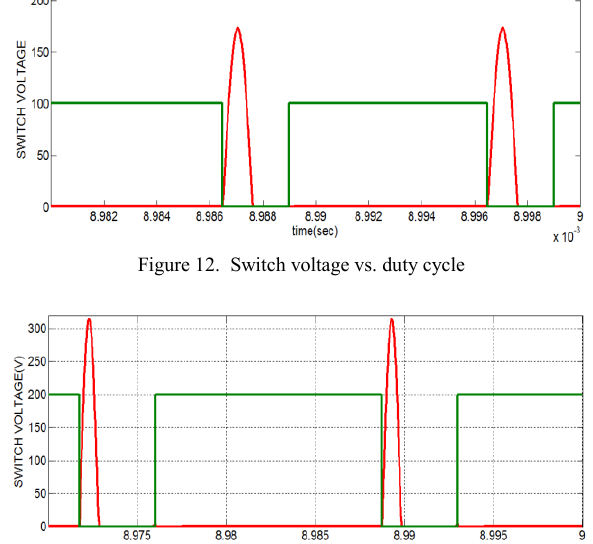
Fig. 11 Resonant Current at maximum power